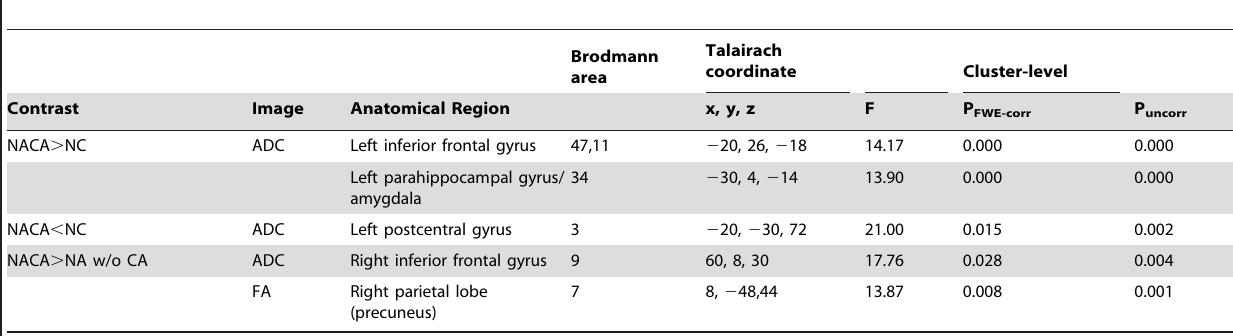
Table 2. Significant differences in the ADC and FA values for the NA/CA, NA w/o CA, and NC groups.